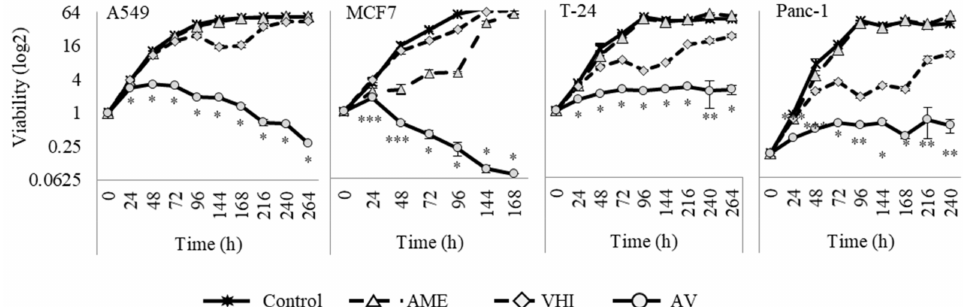
Figure 3. Time-dependent effect of AME, VHI and AV on cancer cells. The cells were treated with 2 mg/mL of AME, VHI or AV and checked for viability at indicated times after the beginning of the treatment. The medium was replaced every 72 h with similar control/treatment-containing medium. The experiment for each cell line was continued either for 264 h after the beginning of the treatment or until the viability of AV-treated cells decreased below 10% of 0 time viability. All values were normalized to the viability of “0” time (the time of treatment addition). Please note that the viability scale is logarithmic (log2). *— p -value < 0.001, **— p -value < 0.01, ***— p -value < 0.05, as compared between AV point and the closest relevant value of other compared groups (control or single